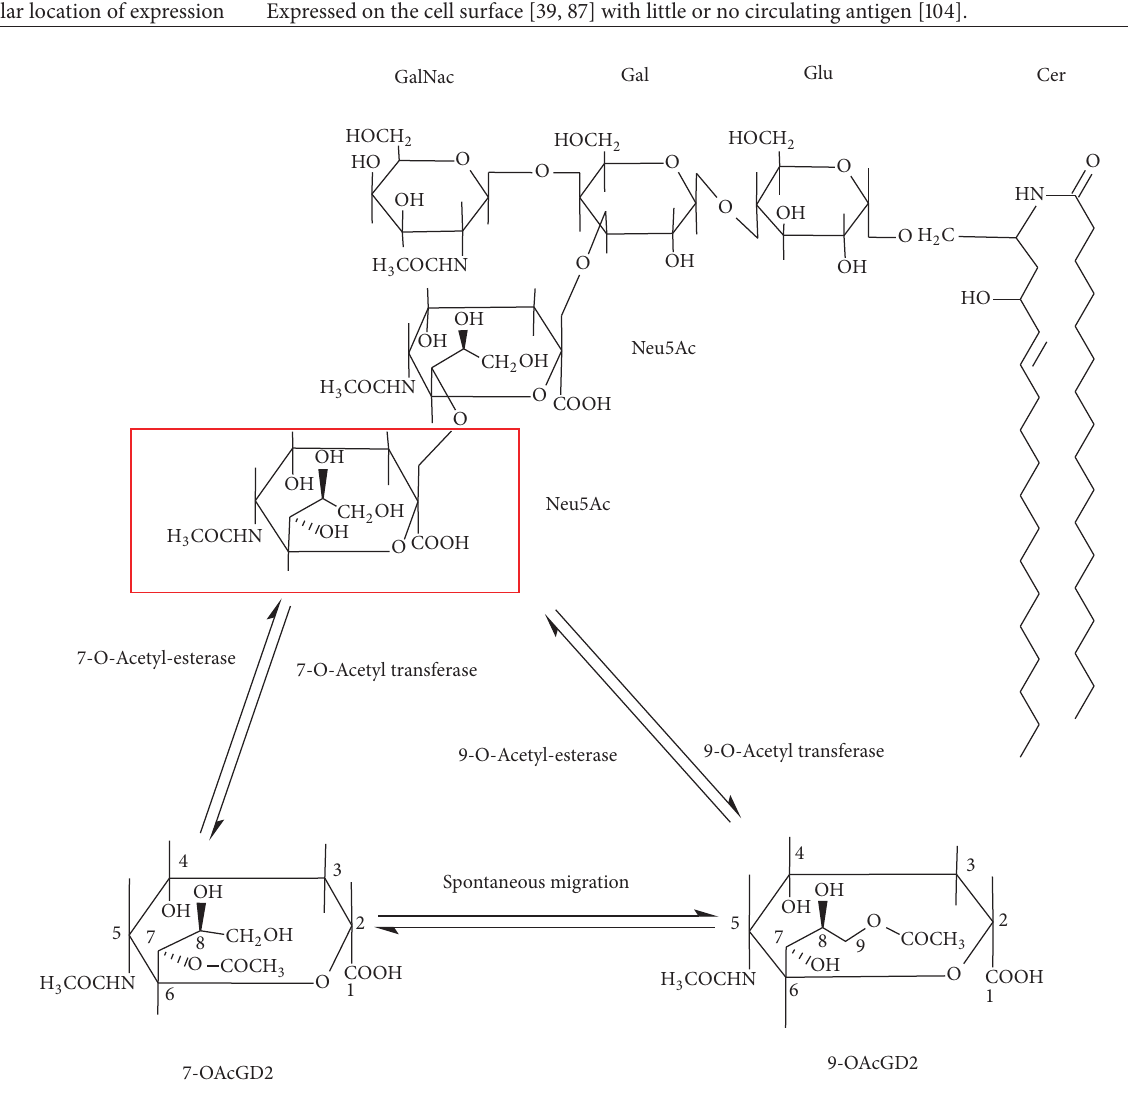
Figure 1: Structure of 9- O -acetyl-GD2. O -acetylated GD2 is constituted by a ceramide chain, which is anchored into plasma membrane, and a hydrophile chain. Oligosaccharide chain and O -acetylation are oriented to extracellular matrix. O -acetyl-GD2 is formed by the addition of an O -acetyl ester to the external sialic acid residue by a 9(7)- O -acetyl transferase. O -Acetyl esters located at the C7 position are mobile and can spontaneously migrate to the C9 position. They can be removed by 9(7)-acetyl esterases. Cer, ceramide; Gal, galactose; GalNAc, N -acetylgalactosamine; Neu5Ac, N -acetylneuraminic